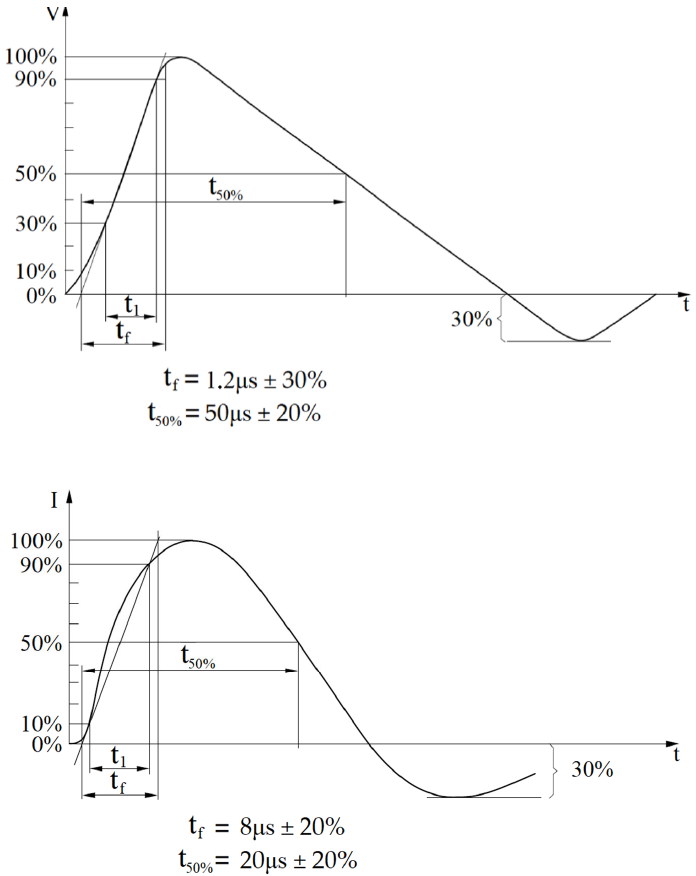
Figure 3. Normalized open circuit voltage of 1.2/50 µ s and short circuit current of 8/20 µ s CWG surge waveform. Surges are typically performed in both CM (line to ground) and DM (line to line),